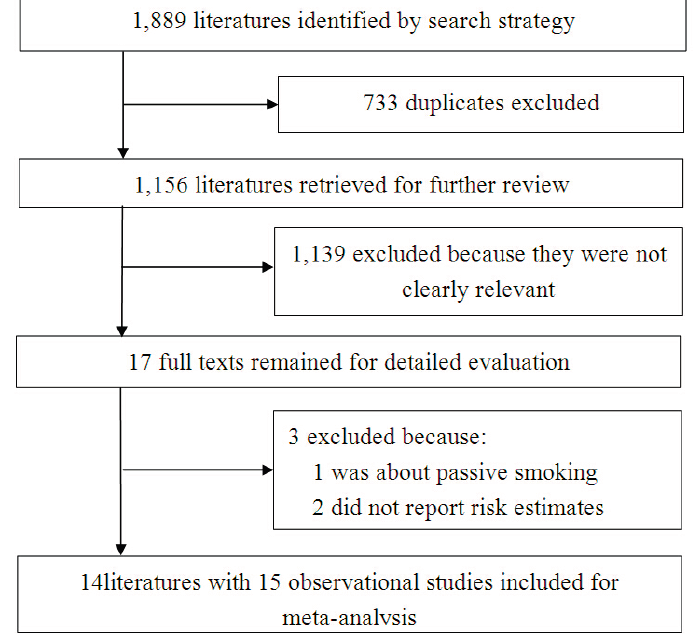
Figure 1. Flow diagram of the study selection